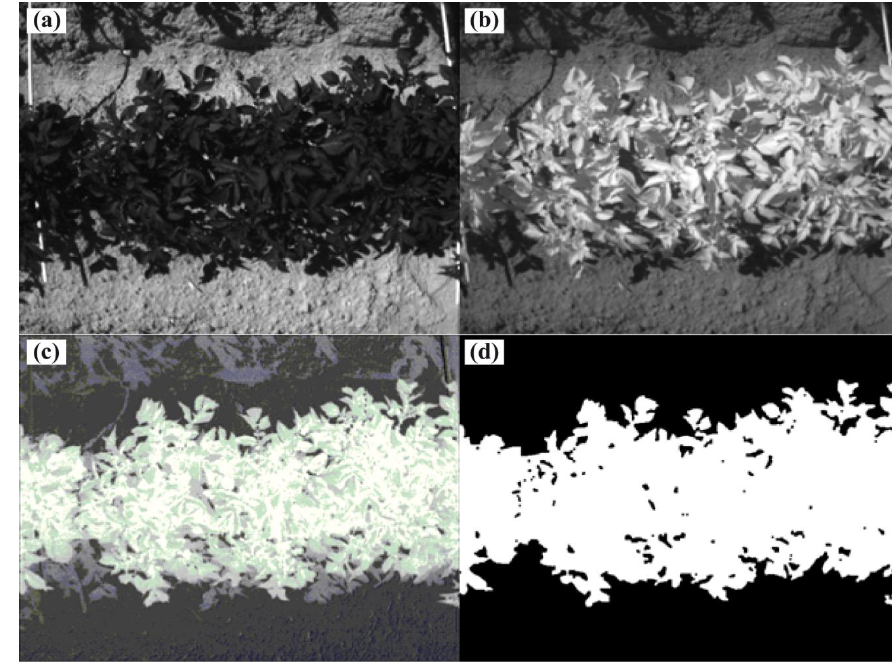
Figure 2. Potato plants detected using a multispectral camera. The red channel ( a ), and the NIR channel ( b ) were used to calculate the NDVI ( c ) and the binary images ( d ) through